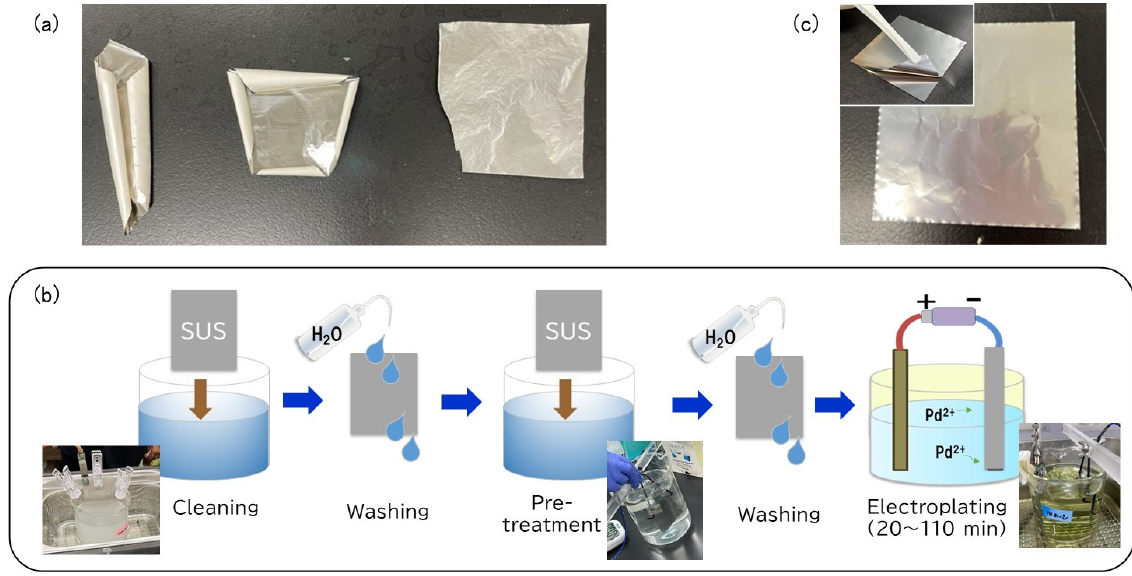
Figure 1. ( a ) Photograph of the plated Pd films prepared under conventional plating conditions. The film was neither a single flat one, due to the stress caused by hydrogen absorption during the plating process, nor was it broken when peeled from an SUS (stainless steel) substrate. ( b ) Schematic of each process involved in electroplating. No special processes were used; only general-purpose equipment was used. ( c ) Collected single flat pure-Pd-plated film. The inset depicts the process of peeling the plated film from a substrate.